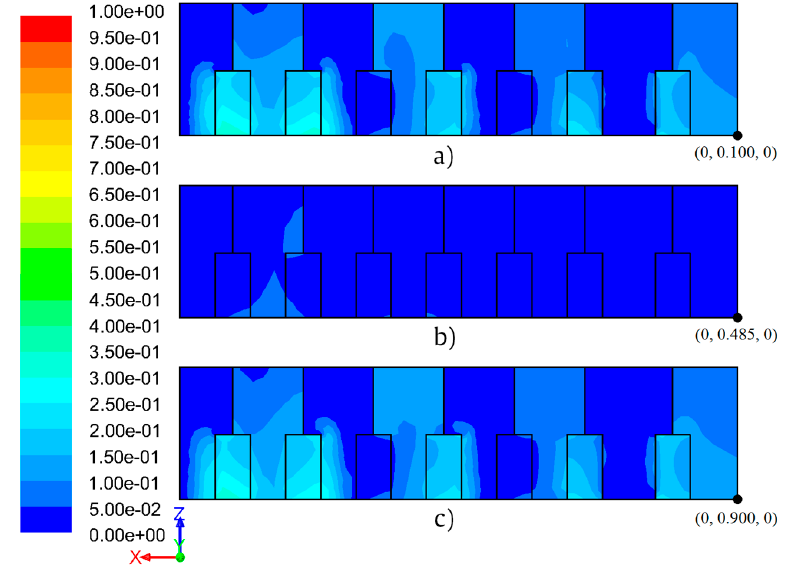
Figure 7. The results of the field of temperature in the x–z plane through the planes: ( a ) y adm = 0.100; ( b ) y adm = 0.485; and ( c ) y adm = 0.900.